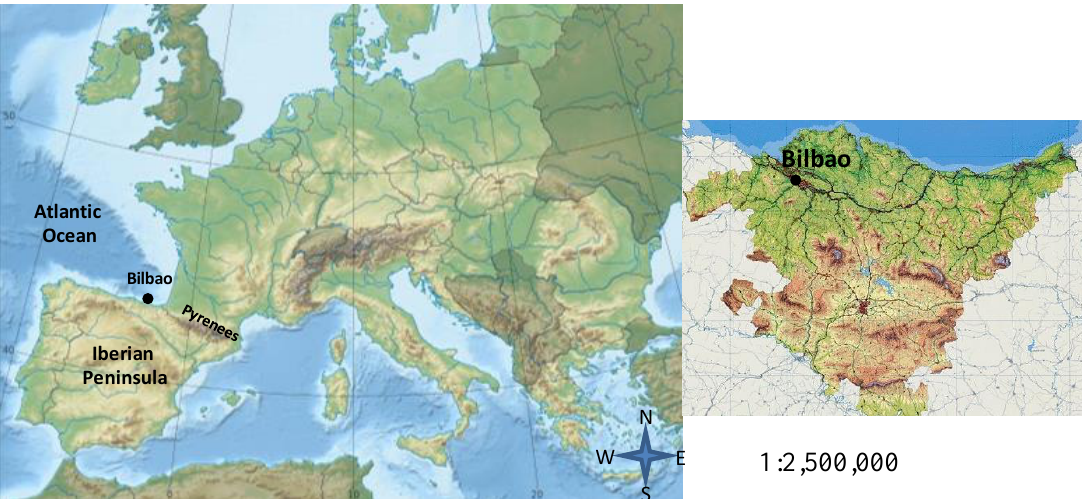
Figure 1. Location of the sampling site in the northern area of the Iberian Peninsula. (Figure 1 is